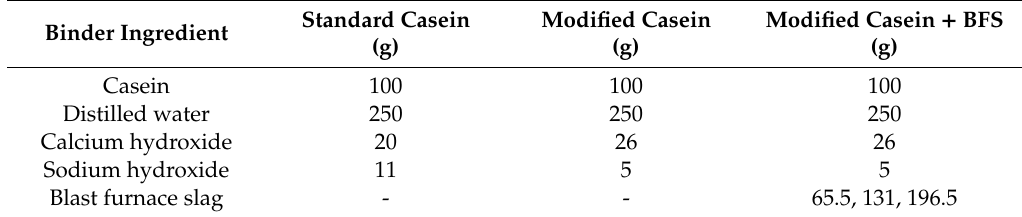
Table 4. Composition of three casein binders.